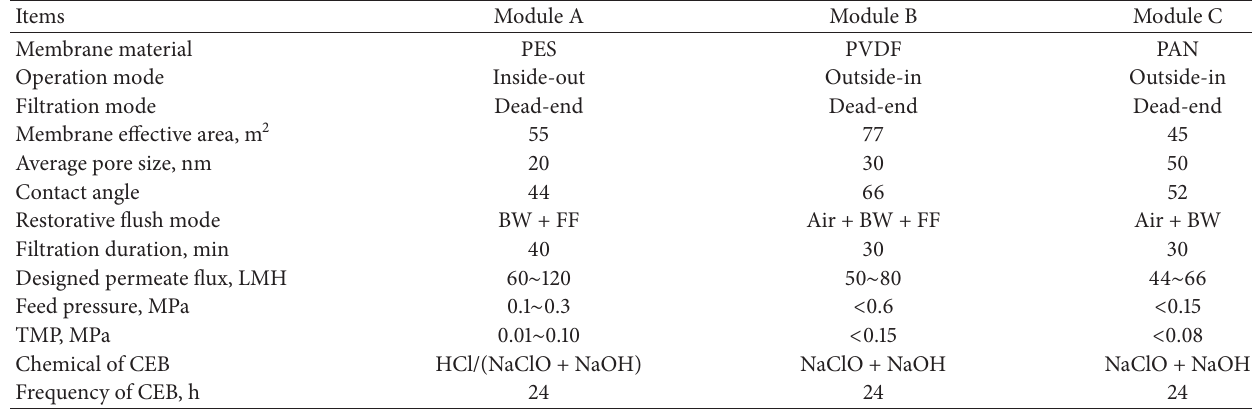
Table 1: Membranes characteristics and operation parameters of the UF